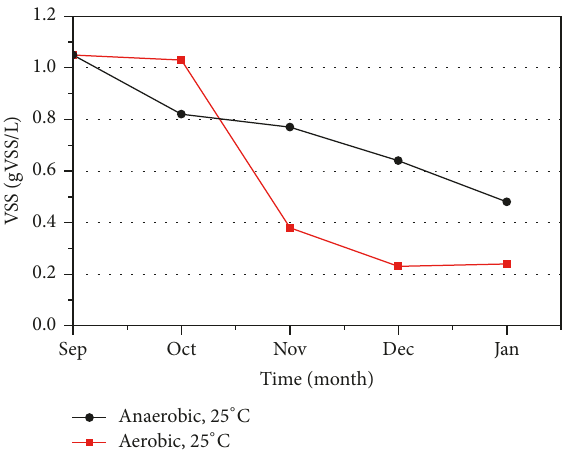
Figure 2: Variation of VSS during 120 days.